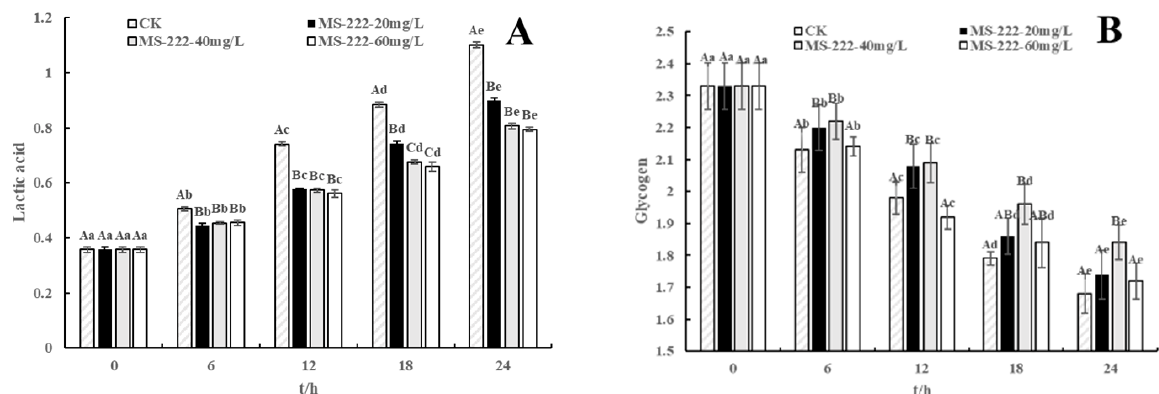
Figure 3. Flesh glycogen ( A ) and lactic acid ( B ) changes in turbot affected by transport stress. Different capital letters indicate that there is a significant difference in the average between the groups. Different lowercase letters indicate significant differences in the average of each group ( p < 0.05). CK, control group.